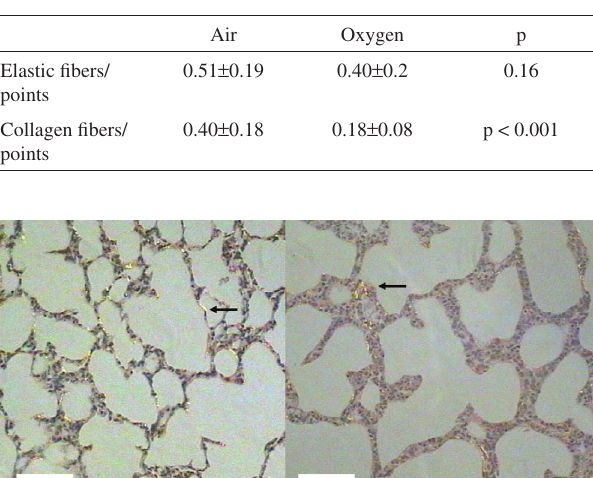
Figure 1 - Panel A:Hematoxilin-eosin stained section (magnification X20). Normal development of the preterm rabbit lung with alveoli of normal size and number. Panel B: After 11 days of hyperoxic challenge there is an evident reduction in alveolar number, with evident accumulation of inflammatory cells in the intersticium. Table 3 - Collagen and elastin content